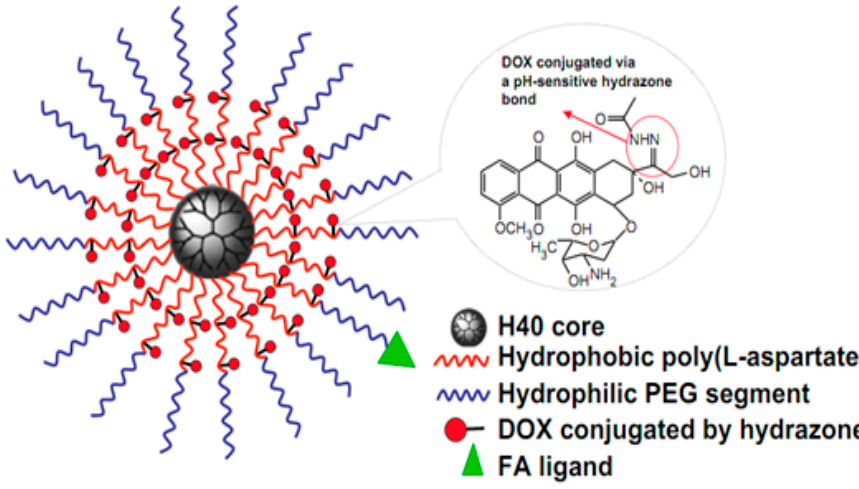
Figure 6. Diagram showing Dox conjugated multi-arm-block copolymer. Reproduced with permission from [141]. Copyright 2009, Elsevier.